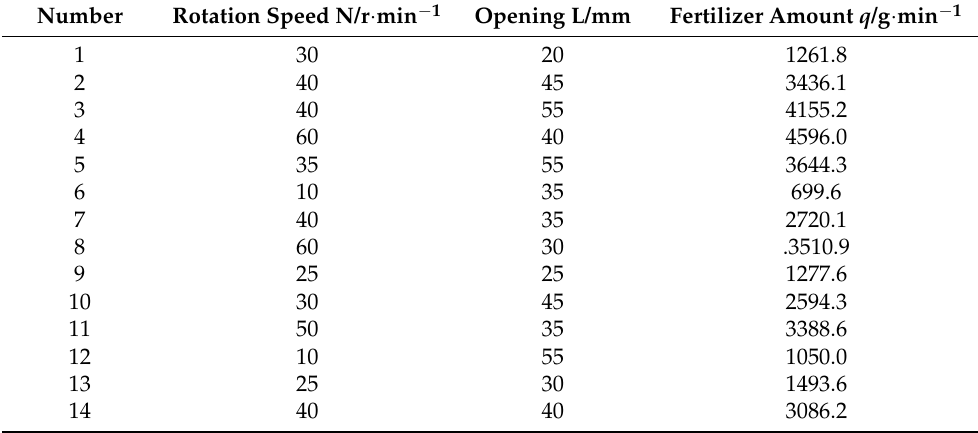
Table 1. Test Sets.